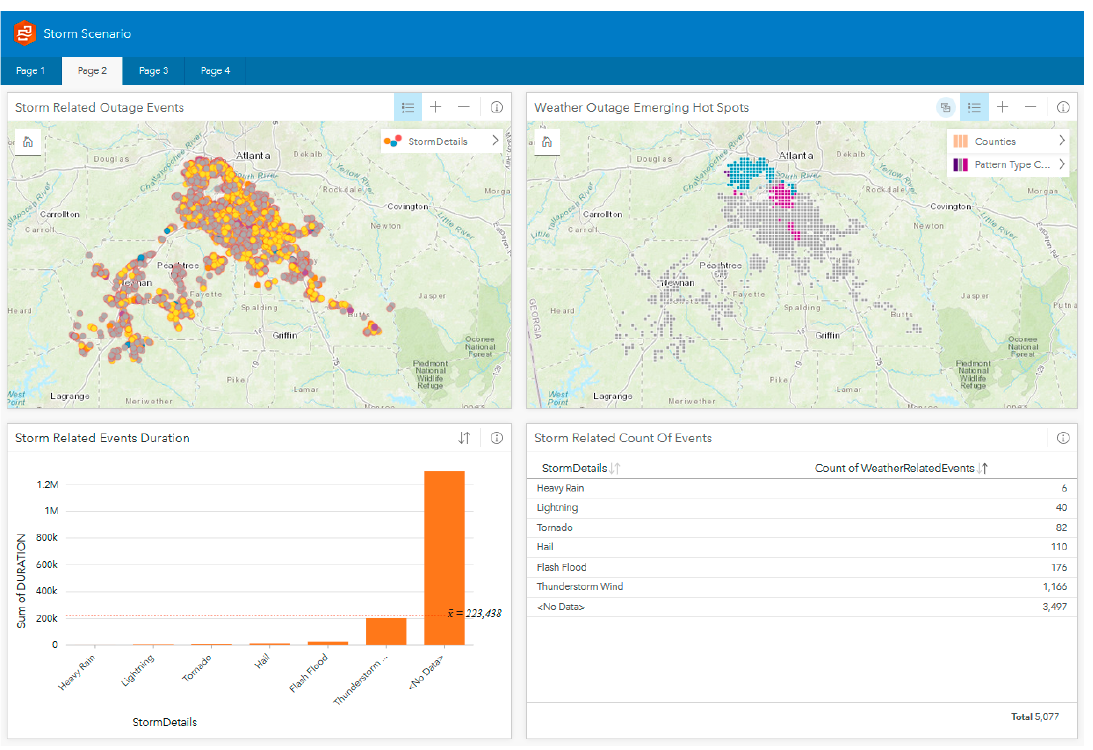
Figure 4. Challenge 1—Storm Scenario Workbook—Page